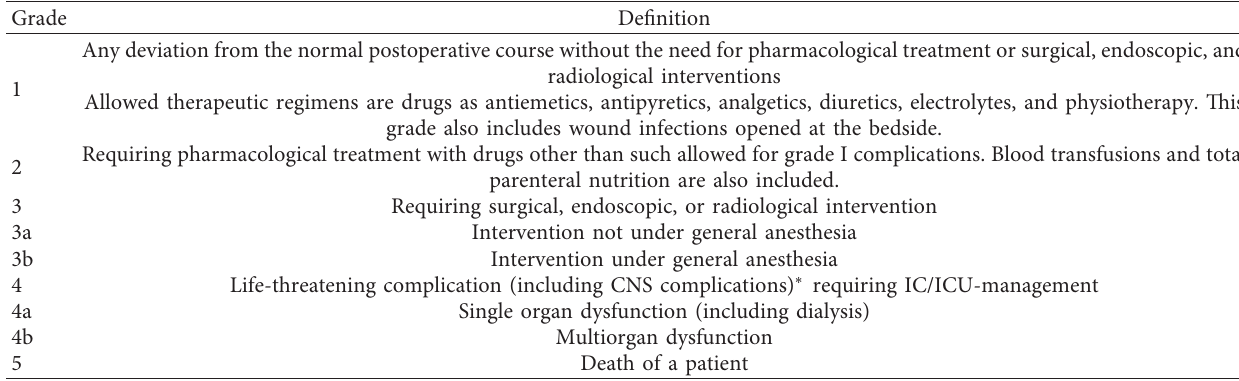
Table 1: Classification of surgical complications (Clavien–Dindo